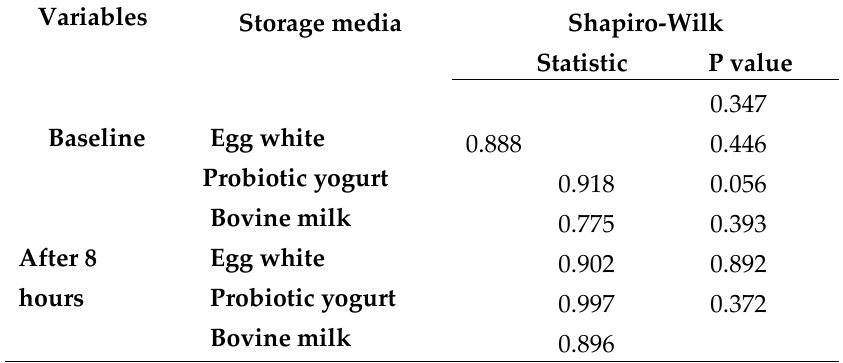
Table 3: Normality test of granularity diameter among periods and storage media